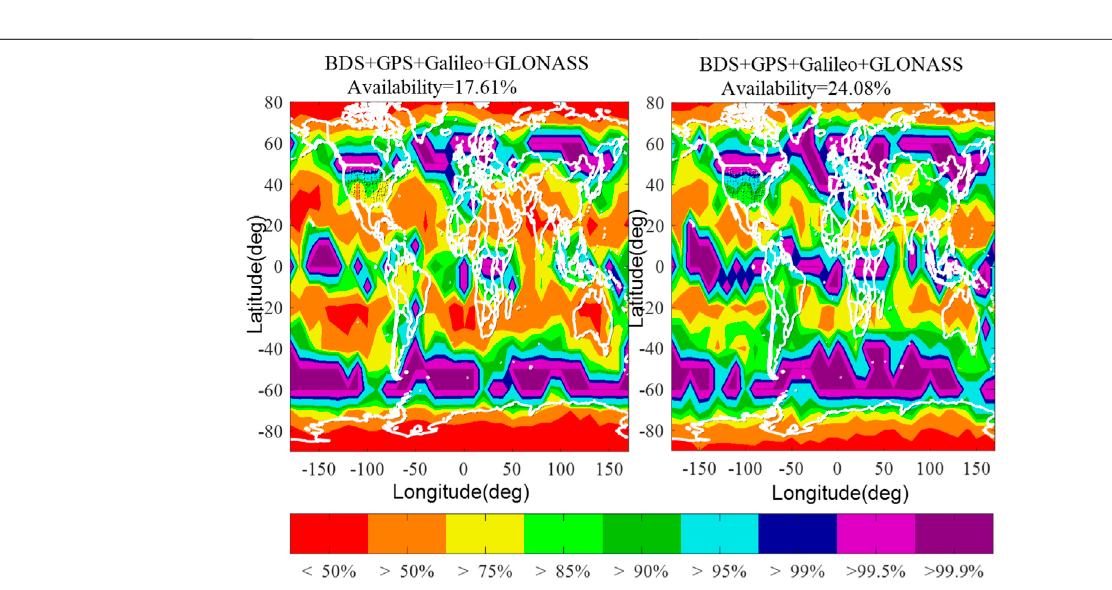
FIGURE 10 | Availability before and after four-constellation optimization under the condition of VAL = 15 m.